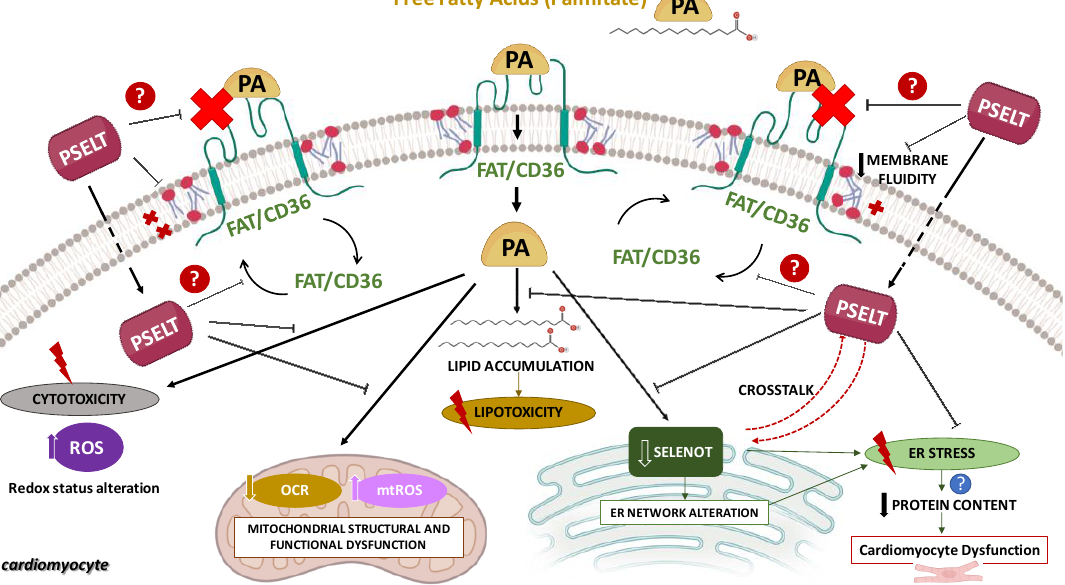
Figure 8. Schematic molecular mechanisms underlying the protective effect of the redox-active motif of SELENOT (PSELT) against palmitate-induced lipotoxicity in cardiomyocytes. ER: endoplasmic reticulum; FAT/CD36: cluster of differentiation 36/fatty acid translocase; OCR: oxygen consumption rate; PA: palmitate; mtROS: mitochondrial reactive oxygen species; ROS: reactive oxygen species; SELENOT: selenoprotein T . For further explanation, see text.